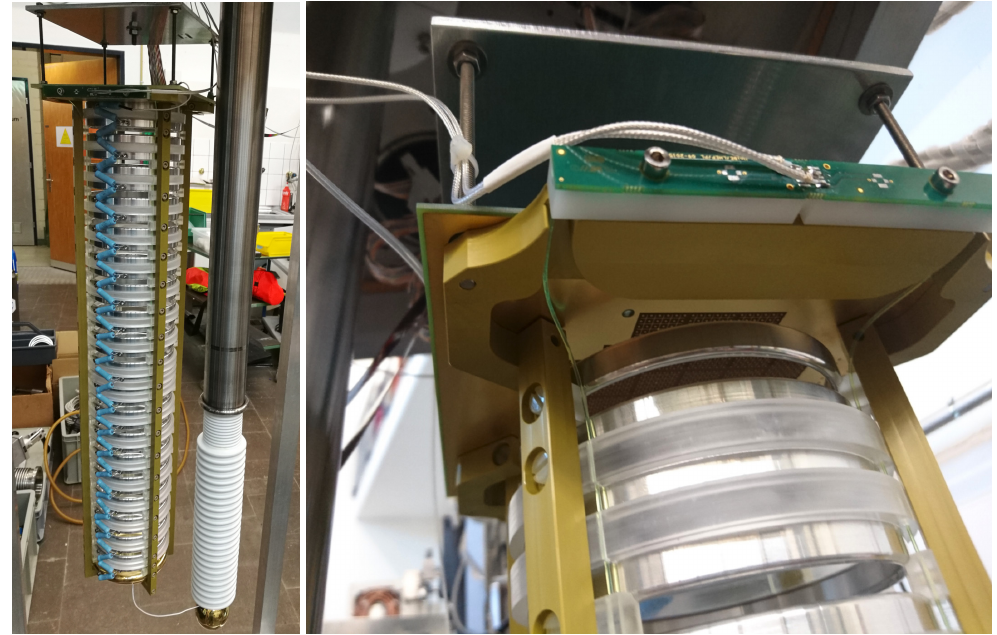
Figure 5. Photographs of the pixel demonstration TPC at Bern, with the HV feedthrough. A close-up of the light collection system shows wavelength shifting fibers coupling SiPMs to the TPB-coated light